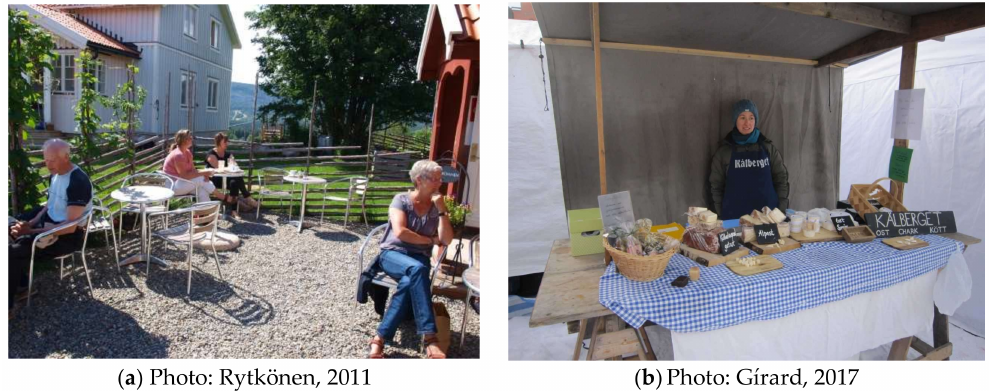
Figure 2. Physical settings for the 2012 and 2017 surveys. ( a ) Customers enjoying the cheese buff é at Kullens farm dairy, June 2011; and ( b ) Gregory market,